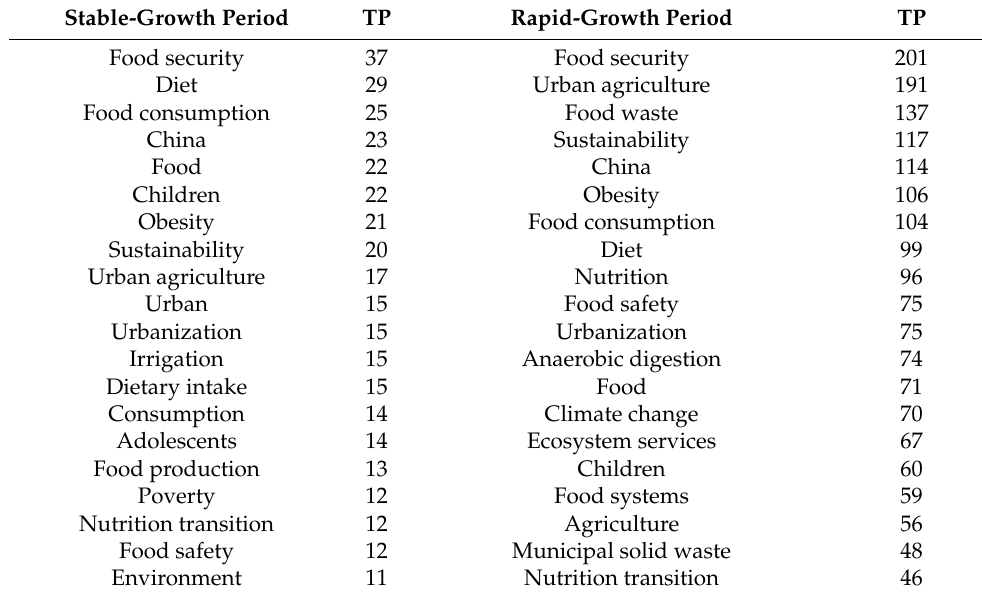
Table 3. The 20 most frequently used keywords over the two